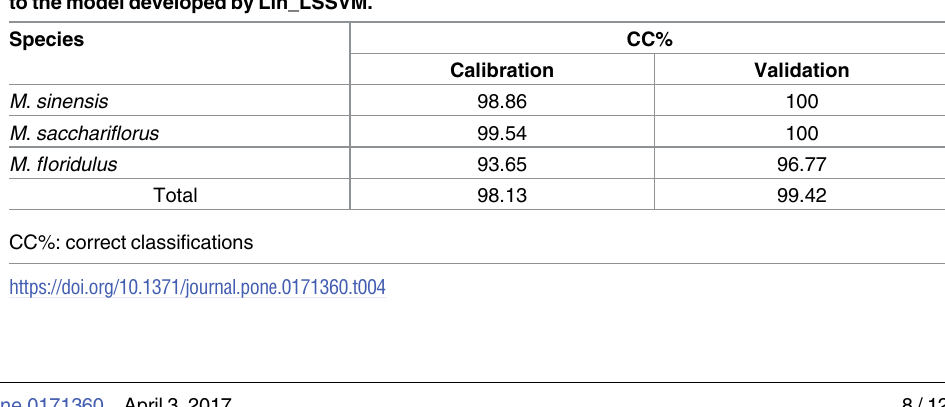
Up to date, there is no report on classification of Miscanthus species using NIR spectroscopy. logical traits [1, 15]. According to the classical botanical classification standard (S3 Table), we examined and recorded all the morphological traits of samples during whole growth period.